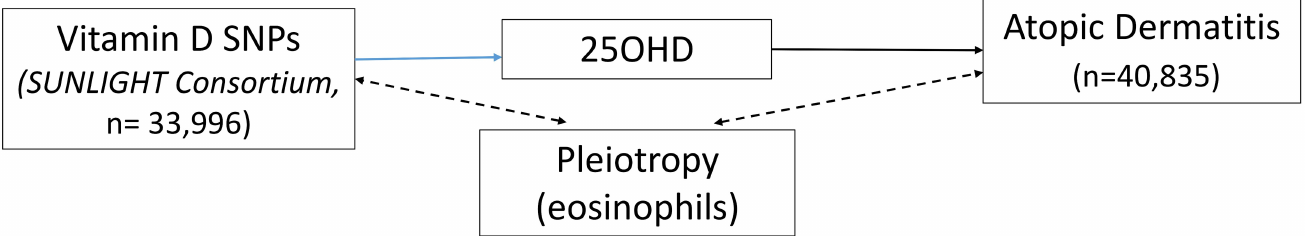
Fig 2. Direct Acyclic Graph (DAG) of the Mendelian randomization analysis for atopic dermatitis. The effect of single-nucleotide polymorphisms (SNPs) on the change in natural log-transformed 25-hydroxyvitamin D (25OHD) levels. SUNLIGHT, Study of UnderlyingGenetic Determinants of Vitamin D and Highly